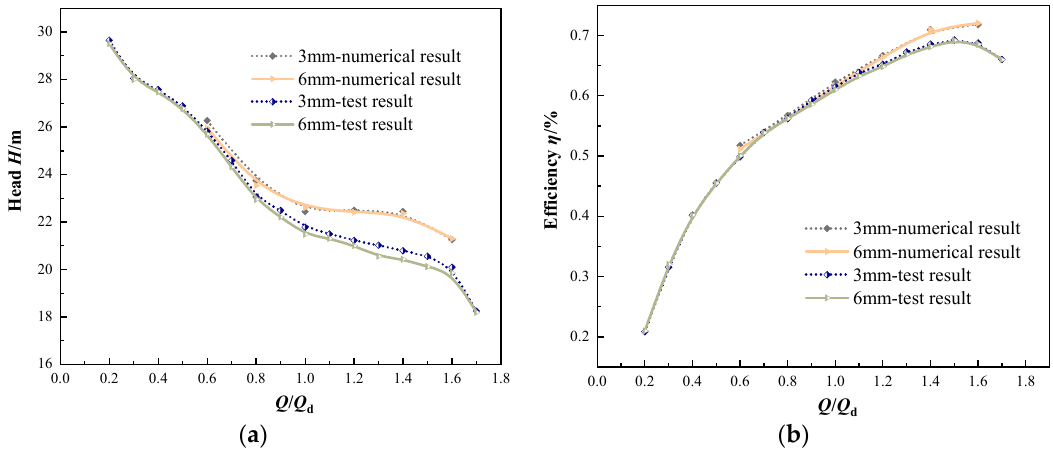
Figure 6. Comparison of experimental and numerical results: ( a ) head; ( b ) efficiency.